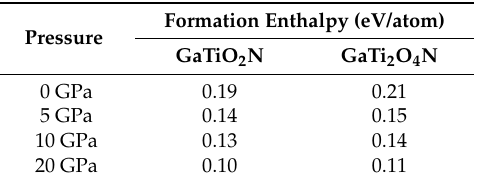
Table 1. Enthalpies of formation of GaTiO 2 N and GaTi 2 O 4 N calculated at 0, 5, 10 and 20